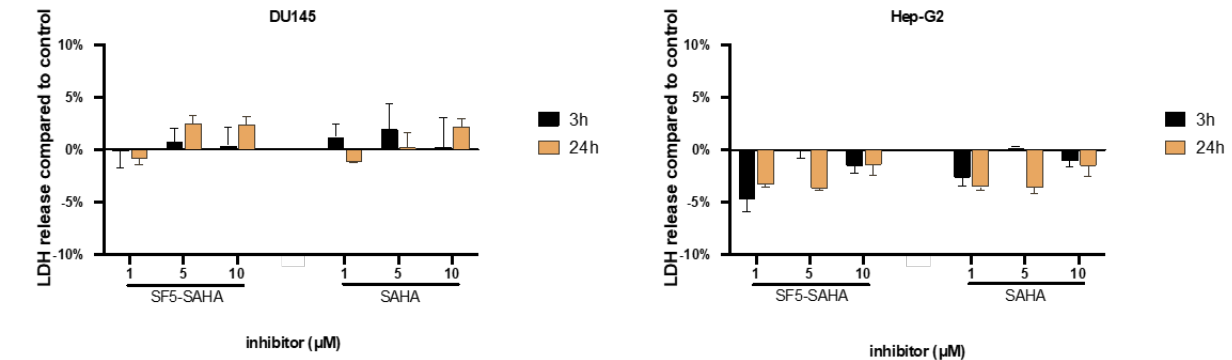
Figure 2. Unspecific cytotoxic effects of SF5-SAHA in DU145 prostate cancer and Hep-G2 hepatoblastoma cells. LDH release of cells was measured after 3 and 24 h of incubation with 1, 5 or 10 µM of SF5-SAHA or SAHA. Results show changes in LDH release relative to untreated controls. Data are given as percentage changes relative to basal LDH release of controls. Means ± SEM of n = 3 independent experiments.